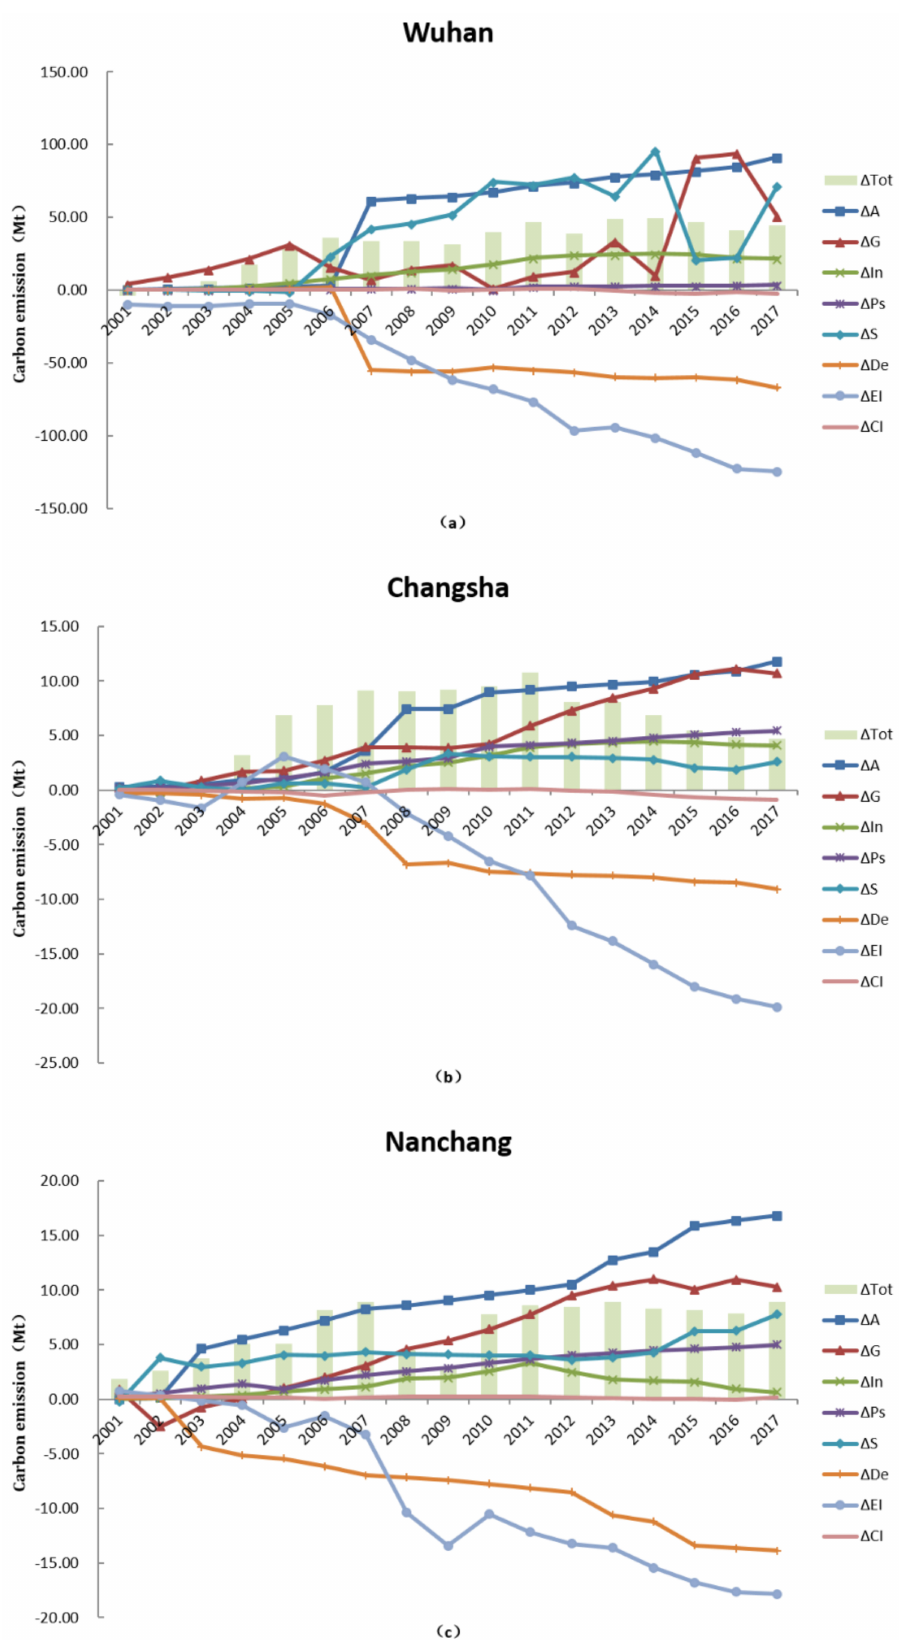
Figure 5. The factors causing carbon emissions in ( a ) Wuhan, ( b ) Changsha and ( c ) Nanchang by a time